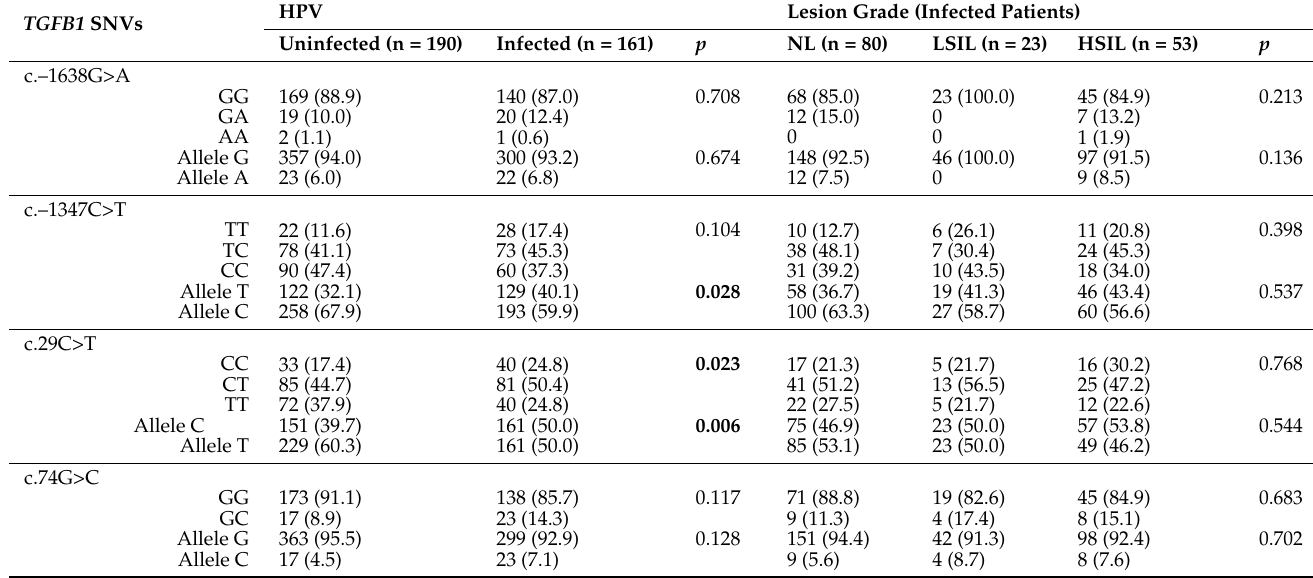
Table 2. TGFB1 genetic variants in HPV infection and cervical lesion status.